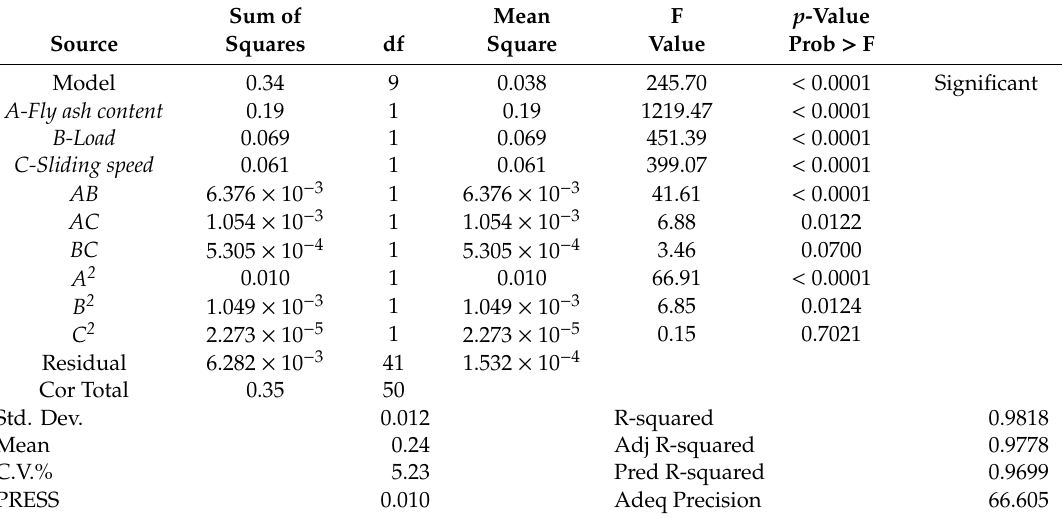
Table 8. ANOVA for Response Surface Quadratic model (coe ffi cient of friction